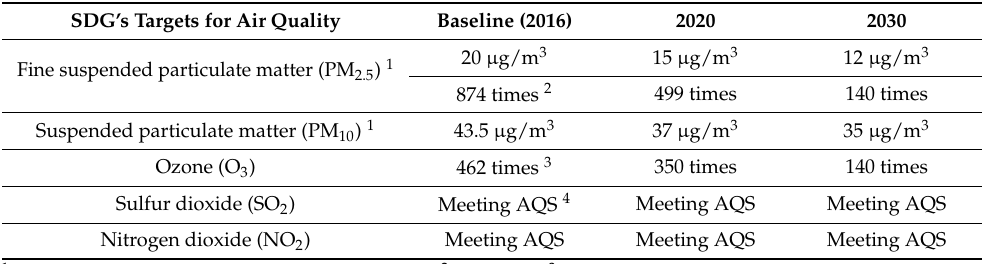
Table 7. The goals of Taiwan’s SDGs for air quality by 2020 and 2030. SDG’s Targets for Air